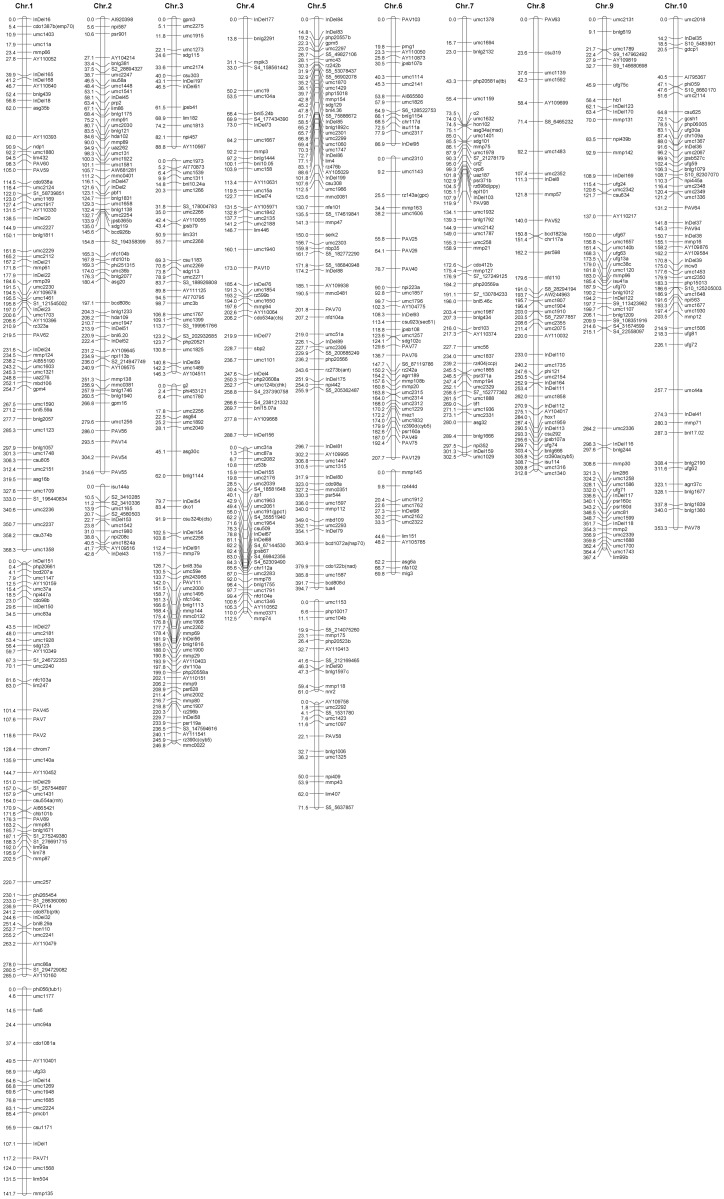
Linkage map generated from 302 individuals.Each chromosome is comprised of one or more LGs and each LG is represented by one bar. The bars of each chromosome were aligned vertically and not according to the order of chromosome framework. The numbers on the left of the bar represent the genetic position of markers as evaluated by the distance function of Kosambi in cM. The names on the right side of the bar indicate the markers.